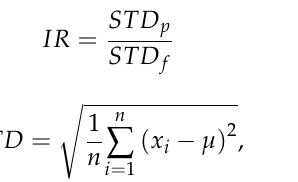
Figure 11. Aeromagnetic interference model: ( a ) Flight C; ( b ) Flight D.